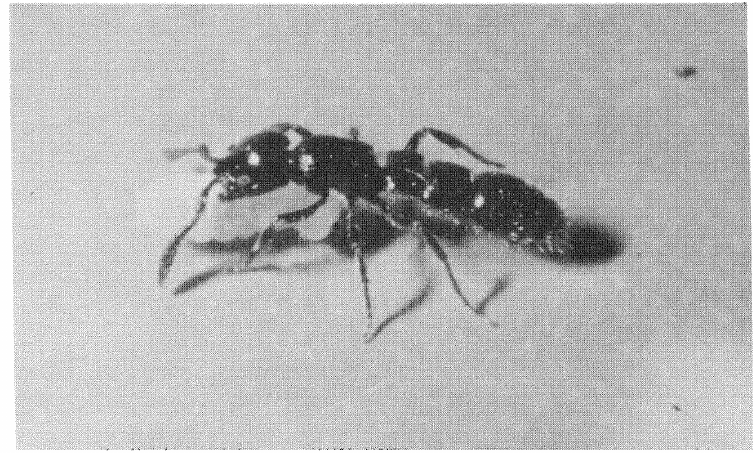
Figure 8. Cerapachys worker carrying a larva during nest